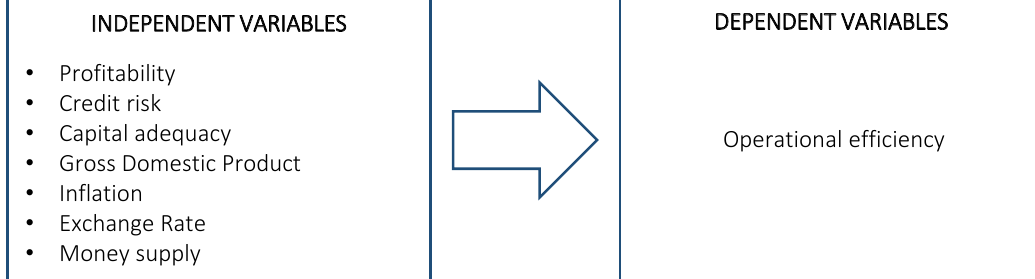
Figure 1. Conceptual